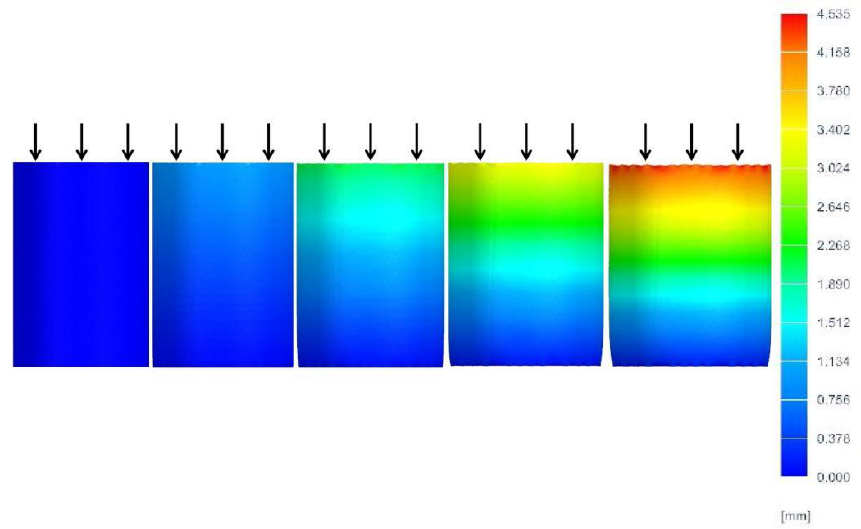
Figure 5. Compression deformation simulation diagram of the print component without support.